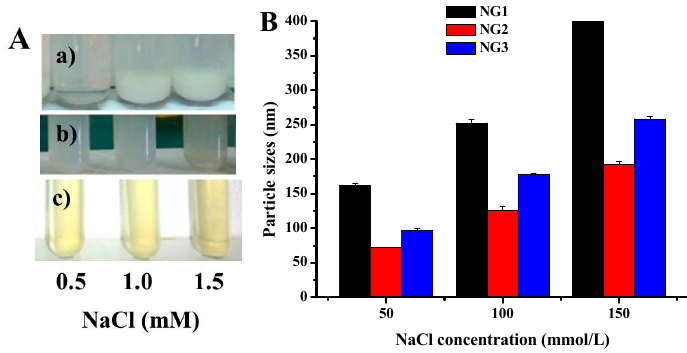
Figure 9 . Influences of NaCl concentration on visual appearance ( A ) and the particles sizes ( B ) of NG1 ( a ), NG2 ( b ) and NG3 ( c ). The data with different lowercase letters in the same test are significantly ( p < 0.05) different. Table 1. Effect of storage time (30 days) on the particles sizes of NG1, NG2 and NG3; the results are displayed as the mean ± standard deviation ( n = 3).